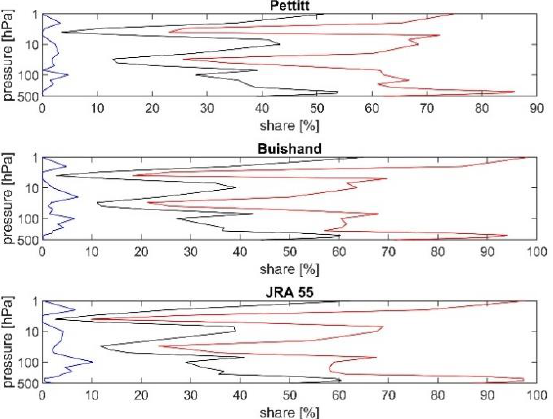
Figure 6. Vertical profile of average (black), minimal (blue) and maximal (red) share of explained discontinuities by the change in 2004 and 2015 to all discontinuities from all months from MERRA- 2 for the Pettitt test ( upper panel ), the Buishand test ( middle panel ) and the Standard Normal Homogeneity test (SNTH, lower panel ).